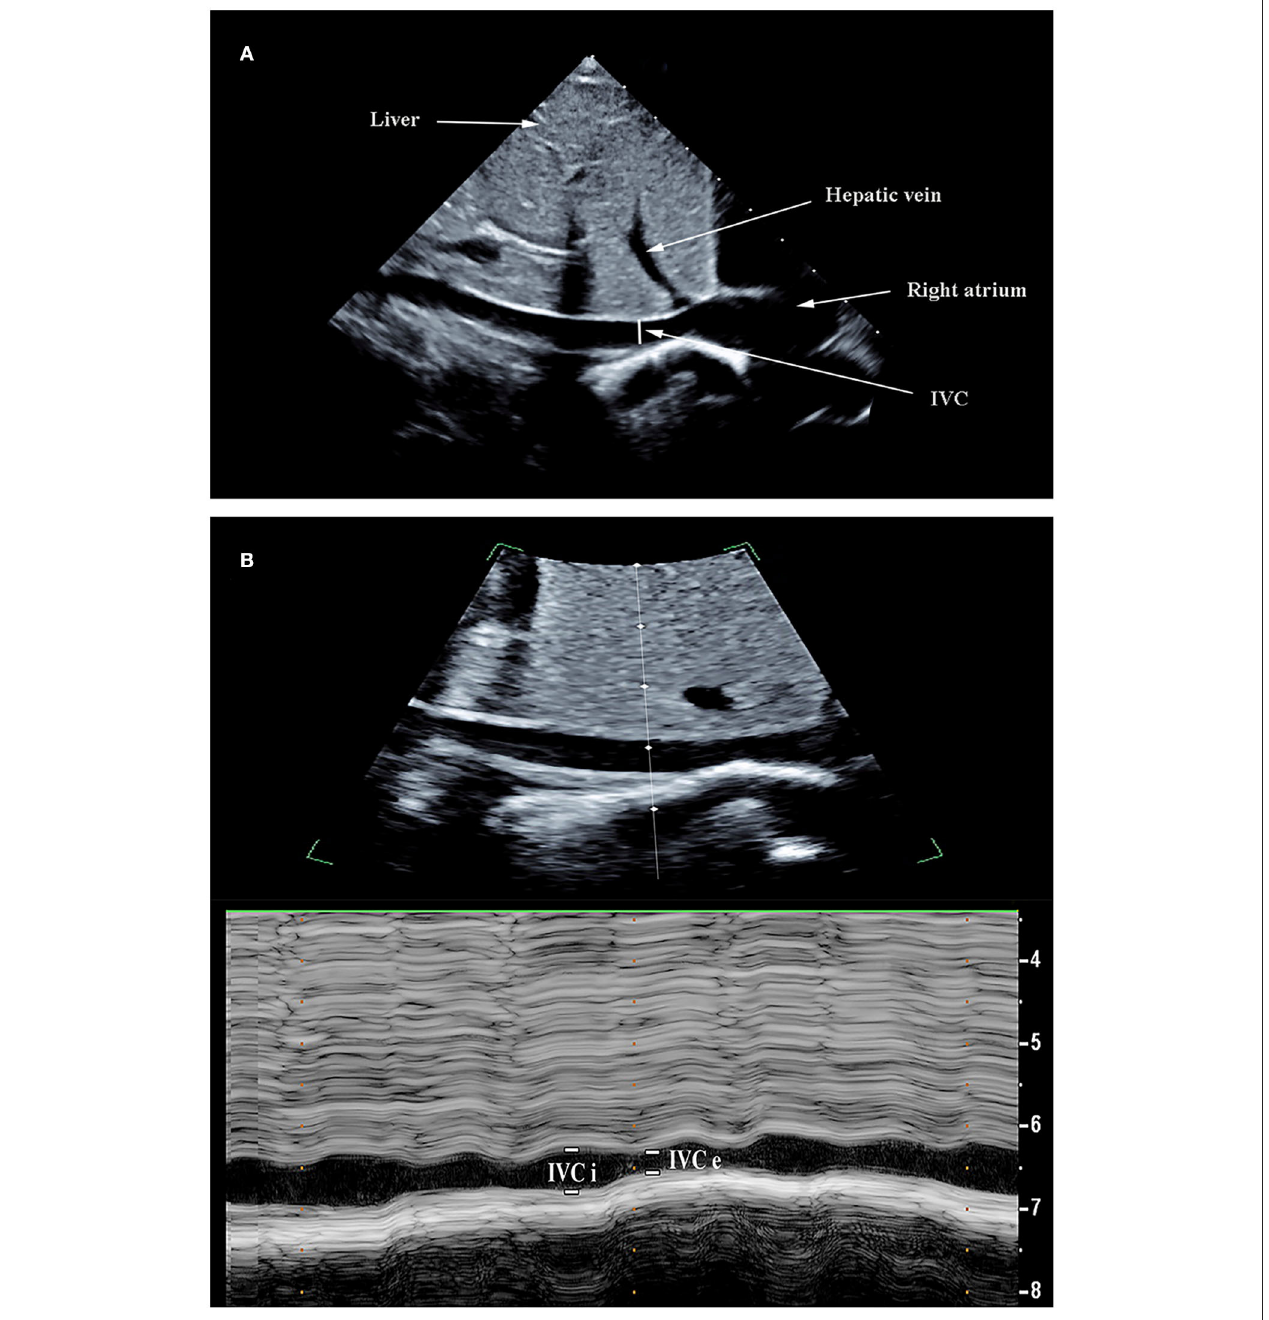
FIGURE 1 | Ultrasonographic measurement of inferior vena cava (IVC) diameters. The IVC images were obtained using the bi-dimensional mode on a subcostal long-axis view (A) . M-mode line was placed through the IVC 1–2 cm caudal from the hepatic vein-IVC confluence and an M-mode tracing obtained. The IVC maximum diameter (IVCmax) and IVC diameter (IVCmin) was measured during the respiratory cycle (B) .